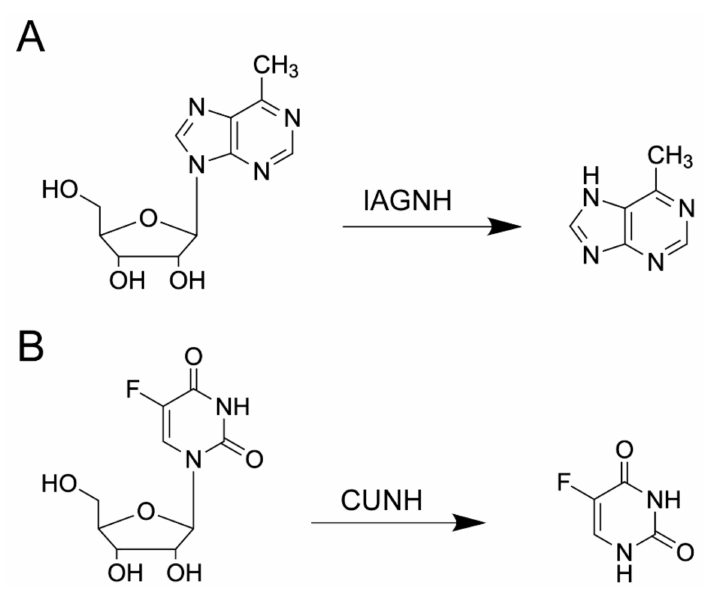
Figure 8. Prodrug activation by NHs. ( A ) IAG-NHs efficiently convert the prodrug 6-methylpurine riboside to 6-methylpurine, whose incorporation in RNA affects protein synthesis. ( B ) Non-specific IU-NHs or pyrimidine-selective CU-NHs hydrolyze the N-glycosidic bond in 5-fluorouridine, lead- ing to release of 5-fluorouracil. The fluorinated pyrimidine is incorporated in nucleotides that hinder the RNA secondary structure, and the deoxy mononucleotide inhibits the key enzyme thymidylate